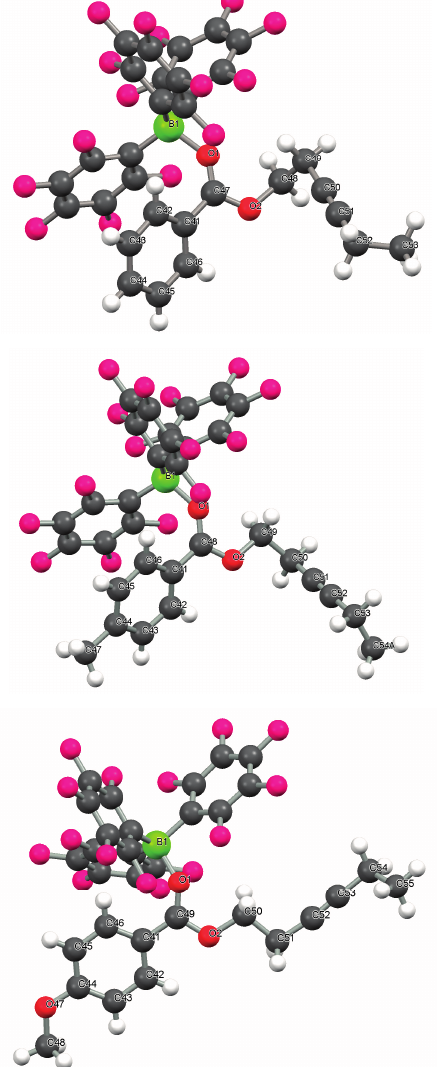
Figure 2. Crystal structure of 2a (top), 2b (middle) and 2c (bottom). C: grey, O: red, H: white, B: yellow-green, F: